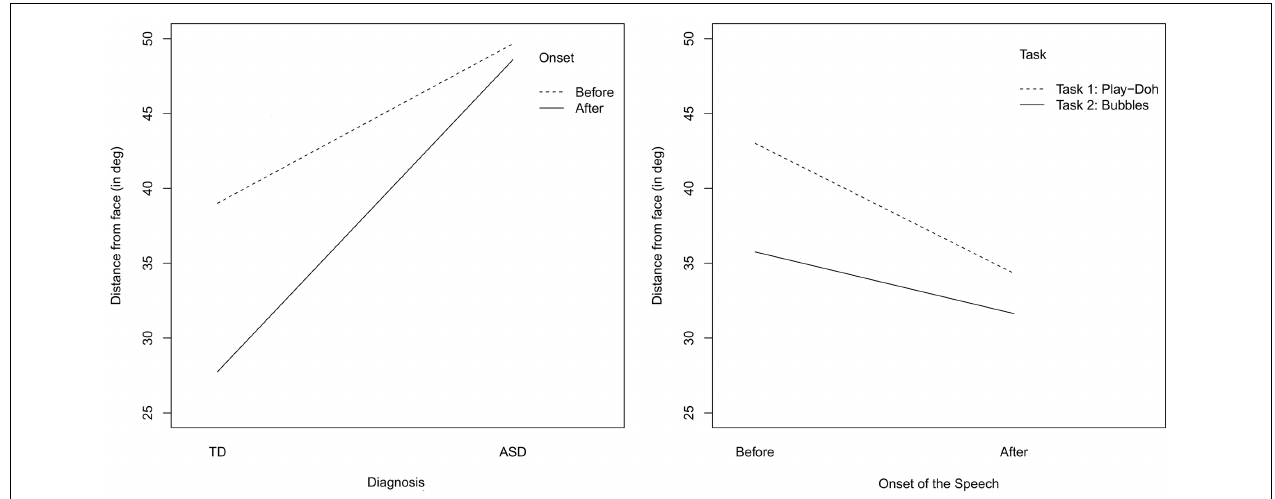
FIGURE 7 | Speaking condition: interaction plots of the average value of the gaze-to-face distance, computed over temporal intervals before and after the onset of the speech. Both the intervals before and after the onset correspond to temporal window of 1200ms (i.e., 30 frames).